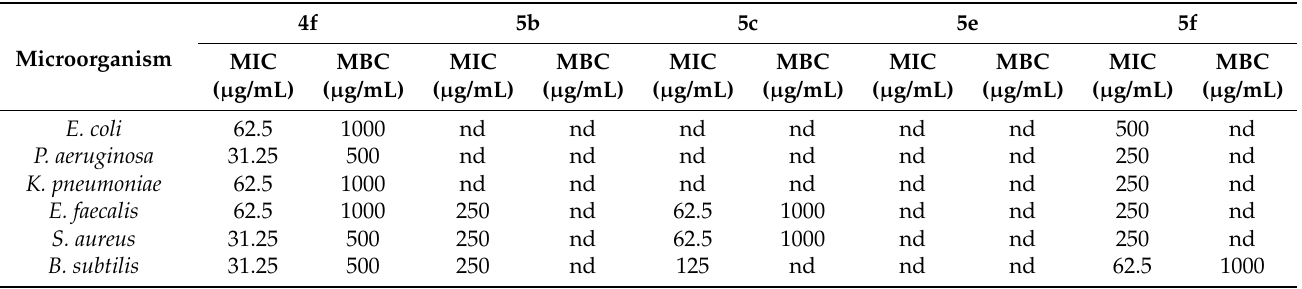
Table 3. MIC ( µ g/mL), MBC ( µ g/mL) of 4f , 5b , 5c , 5e , and 5f towards reference Gram-positive and Gram-negative bacterial strains in dark conditions.